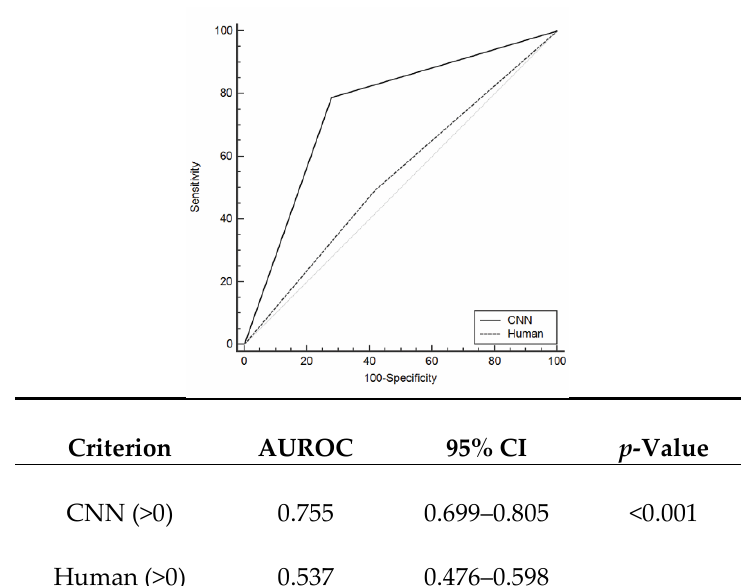
Figure 3. Receiver operating characteristics (ROC) curve according to detections by the convolutional neural network (CNN) and a human evaluator. The difference between areas is 0.163 ( p < 0.001). Area under the ROC (AUROC) curve.